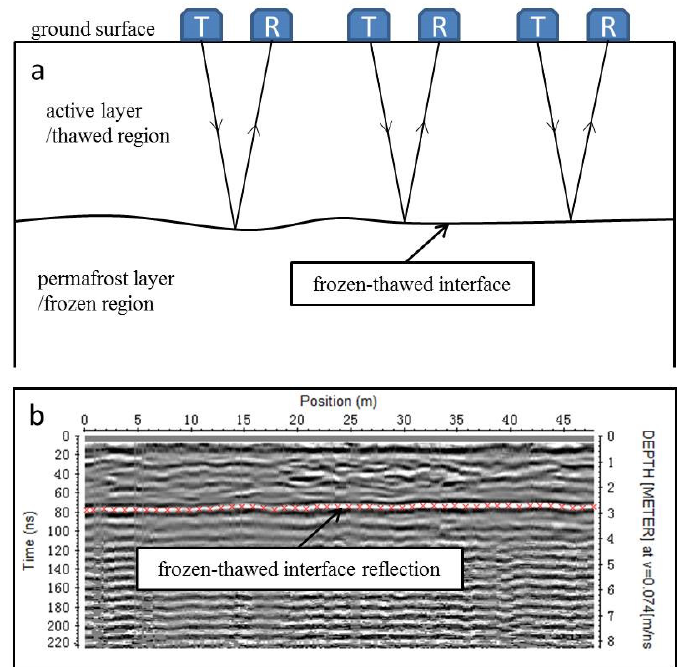
Figure 1. (a) Schematic diagram of active layer detecting with ground-penetrating radar (GPR); (b) real GPR profile data with the interpreted frozen–thawed interface reflection.